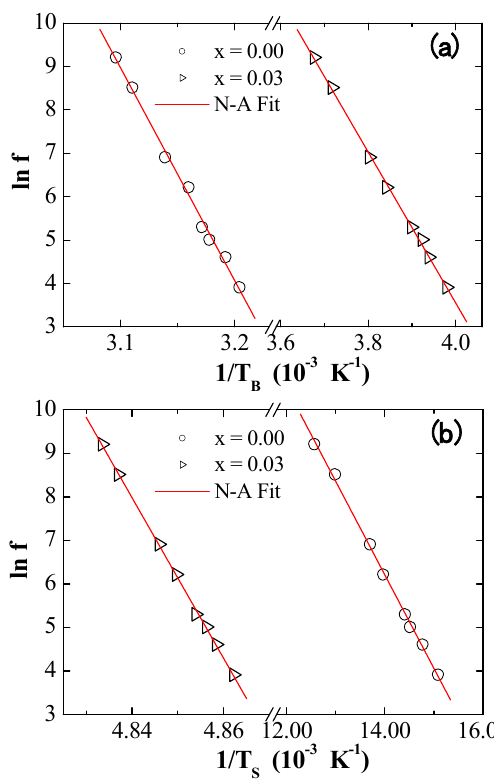
Figure 8. Plots of ( a ) ln ( f ) versus 1/ T B and ( b ) ln ( f ) versus 1/ T s for two selected NiFe 2 − x Dy x O 4 NPs where x = 0.00 and 0.03 fit to the Neel–Arrhenius (N–A law) (solid lines). Table 3. Fitting parameters ( τ o , E 0 / k B and ) of prepared NiFe 2 − x Dy x O 4 ( x = 0.00 and 0.03) NPs estimated using di ff erent